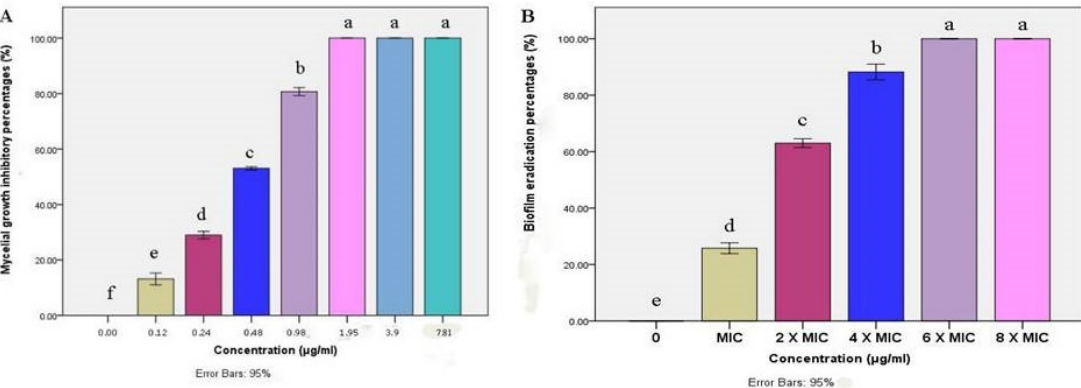
Figure 4. Bar chart showing ( A ) mean mycelial growth inhibitory percentages (%) of M. canis as affected by different concentrations (µg/mL) of BBLP; (B) In vitro biofilm eradication percentages (%) of M. canis as affected by different minimum inhibitory - based concentrations of BBLP; error bars 95% ; Tukey’s post-test: bars sharing the same superscript letter are not significantly different.